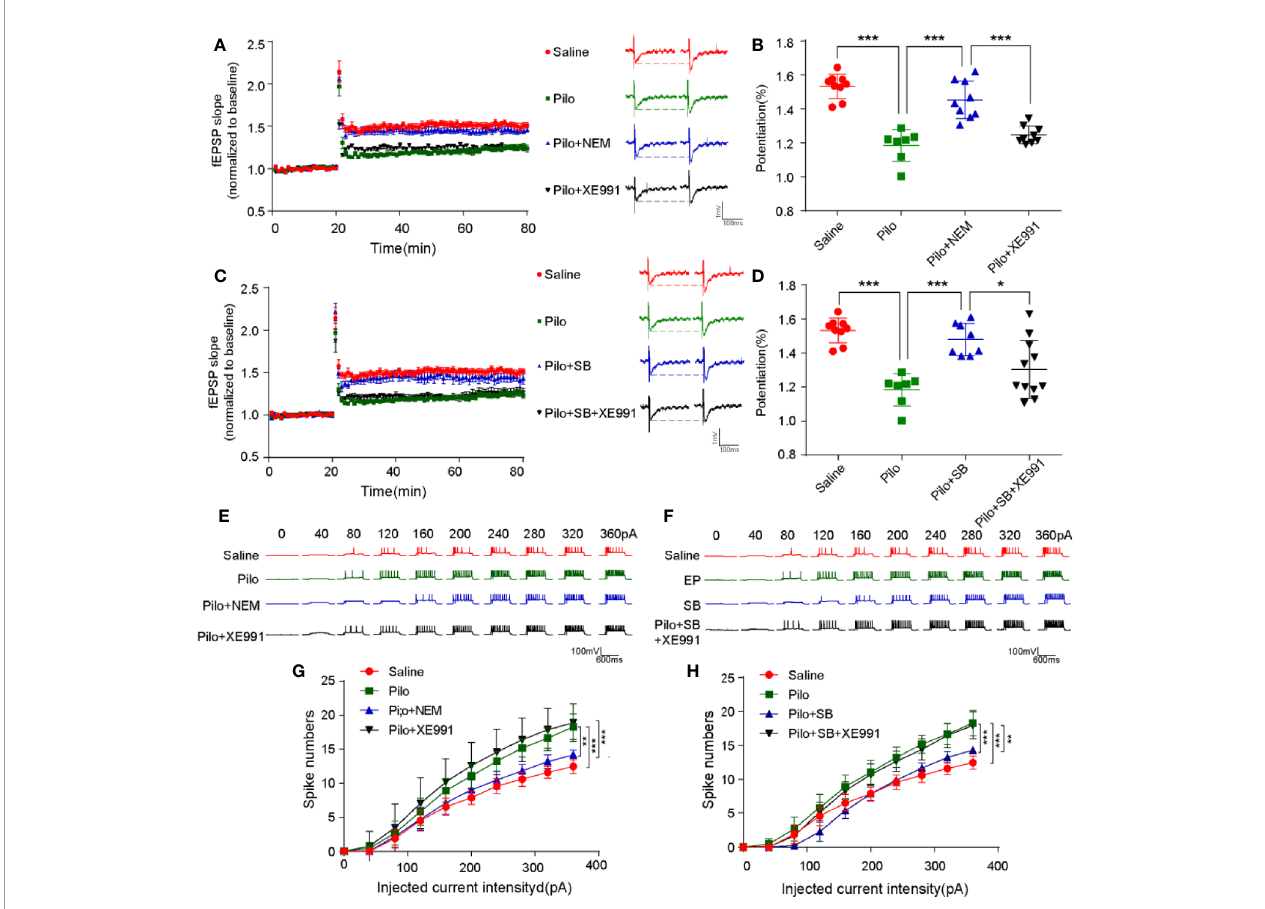
FIGURE 6 | SB271046 rescued synaptic functions by regulating M-channel in chronic epileptic rats. (A, C) LTP recordings from epileptic hippocampal slices after the treatment of 5-HT6R ligands and M-channel ligands. (B, D) Analysis of potentiation among the four groups. The potentiation of LTP in the Pilo group was notably upregulated compared with that in the Saline group, which was reversed by both NEM and SB271046 but not XE991. Moreover, the effect of SB271046 was reversed by XE991. For comparing: ANOVA, F(3,30) = 31.466, p < 0.001; for the Saline group (n=9/5) vs. the Pilo group (n=7/4): p < 0.001; for the Pilo group vs. the Pilo+NEM group (n=9/5), p = 0.0000; for the Pilo+NEM group vs. the Pilo+XE991 group (n=9/5), p < 0.001. For comparing: ANOVA, F(3,31) = 14.287, p < 0.001; for the Pilo group vs. the Pilo+SB group, p = 0.0003; for the Pilo+SB271046 group vs. the Pilo++SB271046+XE991 group (n=11/5), p = 0.0222. Statistical comparisons were performed with one-way ANOVA followed by the Bonferroni post-hoc test (* p < 0.05, ** p < 0.01, *** p < 0.001). (E, G) Representative traces of evoked action potential in response to various depolarization currents injected into individual hippocampal neurons. (F, H) Quanti fi cation of evoked action potentials. (Saline group n=17/6; Pilo group n=16/6; Pilo+NEM group n=17/6; Pilo+XE991 group n=17/6; Pilo+SB271046 group n=17/6; Pilo+SB271046+XE991 group n=17/ 6). Signi fi cance was determined using two-factor mixed ANOVA followed by the Bonferroni post-hoc test. (* p < 0.05, ** p < 0.01, *** p < 0.001). ANOVA, F (3,676) = 13.551, p < 0.001; for the Saline group vs. the Pilo group: p = 0.0002; for the Pilo group vs. the Pilo+NEM group, p = 0.0017; for the Pilo+NEM group vs. the Pilo +XE991 group, p = 0.0001. For comparison: ANOVA, F(3,676) = 10.465, p < 0.001; for the Pilo group vs. the Pilo+SB271046 group, p = 0.0001; for the Pilo +SB271046 group vs. the Pilo++SB271046+XE991 group, p = 0.0024. ‘ n' designates the number of cells followed by number of animals. Data in summary graphs are represented as mean ±